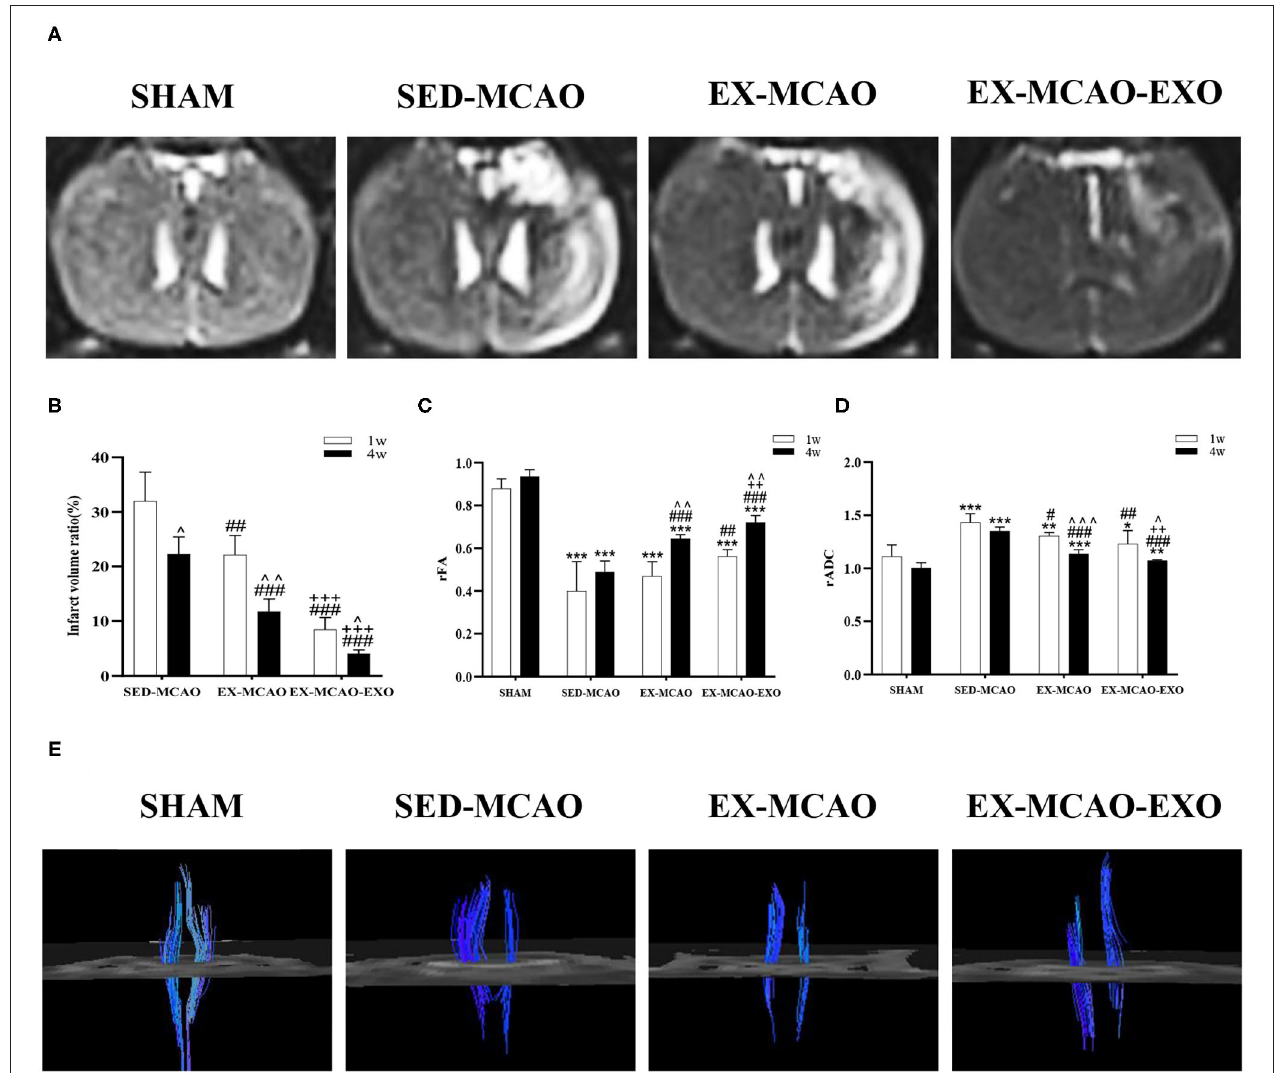
FIGURE 6 | Magnetic resonance imaging of rats after the exercise intervention. (A) Brain transverse spin-spin relaxation time of Mxy weight image (T2WI) sequence images after 4 weeks of intervention. (B) Infarct volume ratio. (C) rFA value after cerebral infarction. (D) rADC value after cerebral infarction. (E) Corticospinal tract tracking diagram after 4 weeks of intervention. ∧ p < 0.05, ∧∧ p < 0.01, and ∧∧∧ p < 0.001 compared with the corresponding parameter at 1 week within groups. * p < 0.01, ** p < 0.05, and *** p < 0.001 compared with the corresponding SHAM group. # p < 0.05, ## p < 0.01, and ### p < 0.001 compared with the corresponding SED-MCAO group. ++ p < 0.01 and +++ p < 0.001 compared with the corresponding EX-MCAO group. Means ± standard deviations, n =